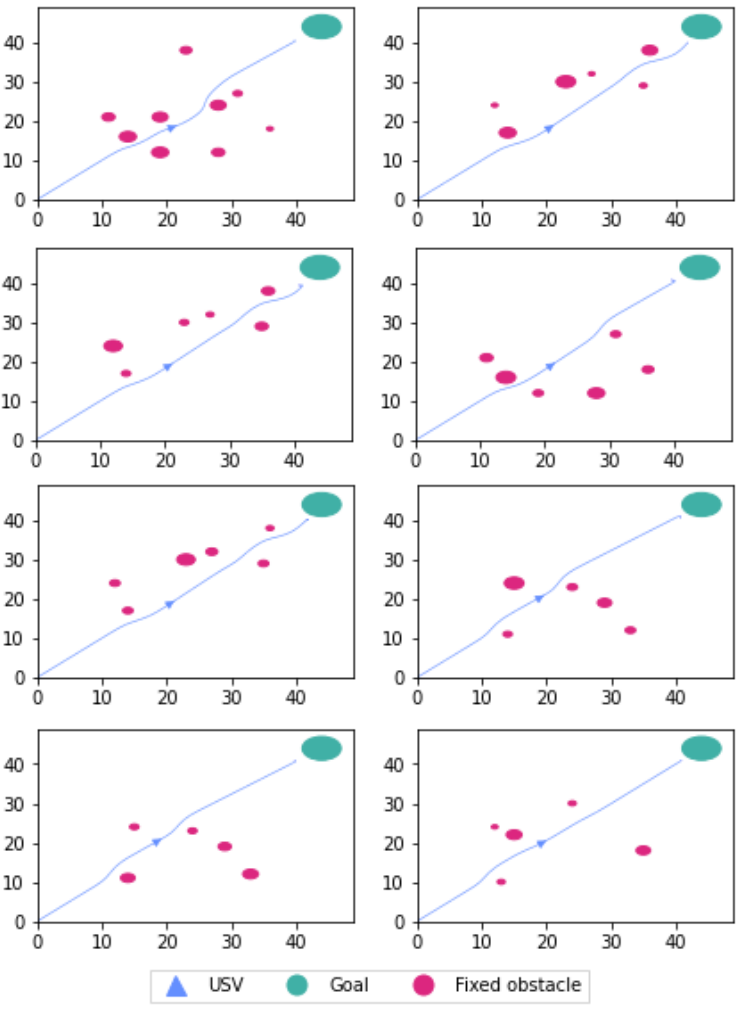
Figure 7. USV path avoiding fixed obstacles.